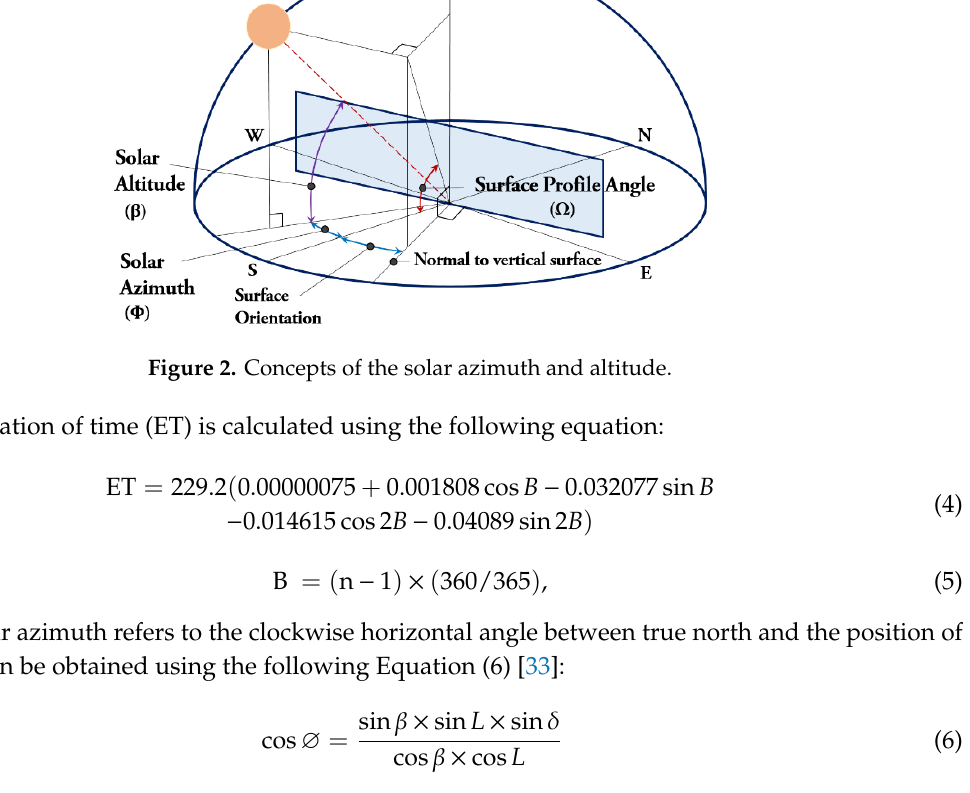
Figure 3. Concepts of the cut-off angle and profile angle.